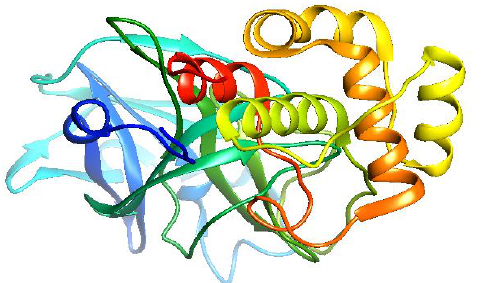
Figure 2. The 3D structure of COVID- 19 main protease